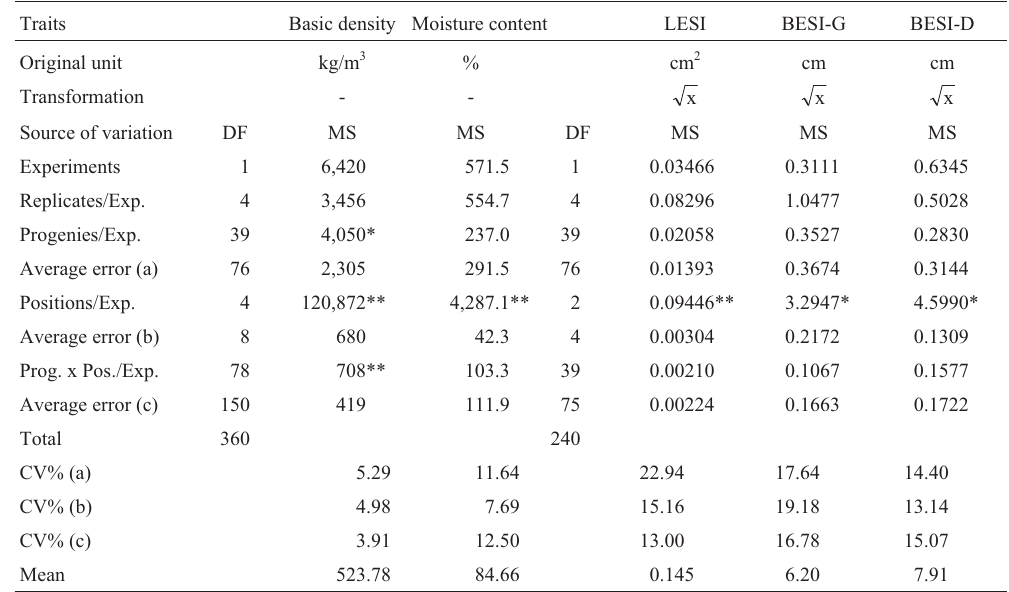
Table1 -Analysisofvarianceforseveraltraitsineight-year-old E.grandis onaplotmeanbasis(twoplants)andfordifferentsamplingtreepositionsand evaluations in logs. Traits Basic density Moisture